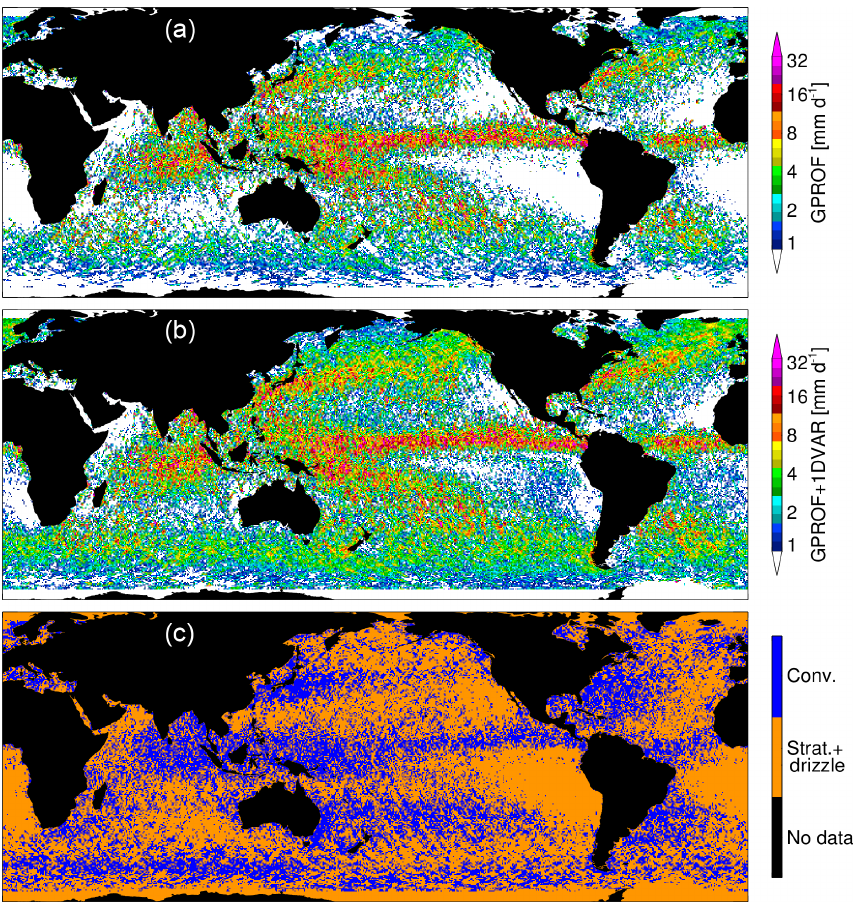
Figure 13. One year of GMI 1DVAR retrievals gridded at 0.5 ◦ resolution. Panel (a) shows GPROF mean rain rates from GMI. Panel (b) shows a combination of GPROF plus 1DVAR-derived rain rates. The 1DVAR solution supersedes GPROF wherever it converged in rain and non-raining conditions with χ 2 < 1 . 0. Panel (c) shows the dominant modes of 1DVAR precipitation